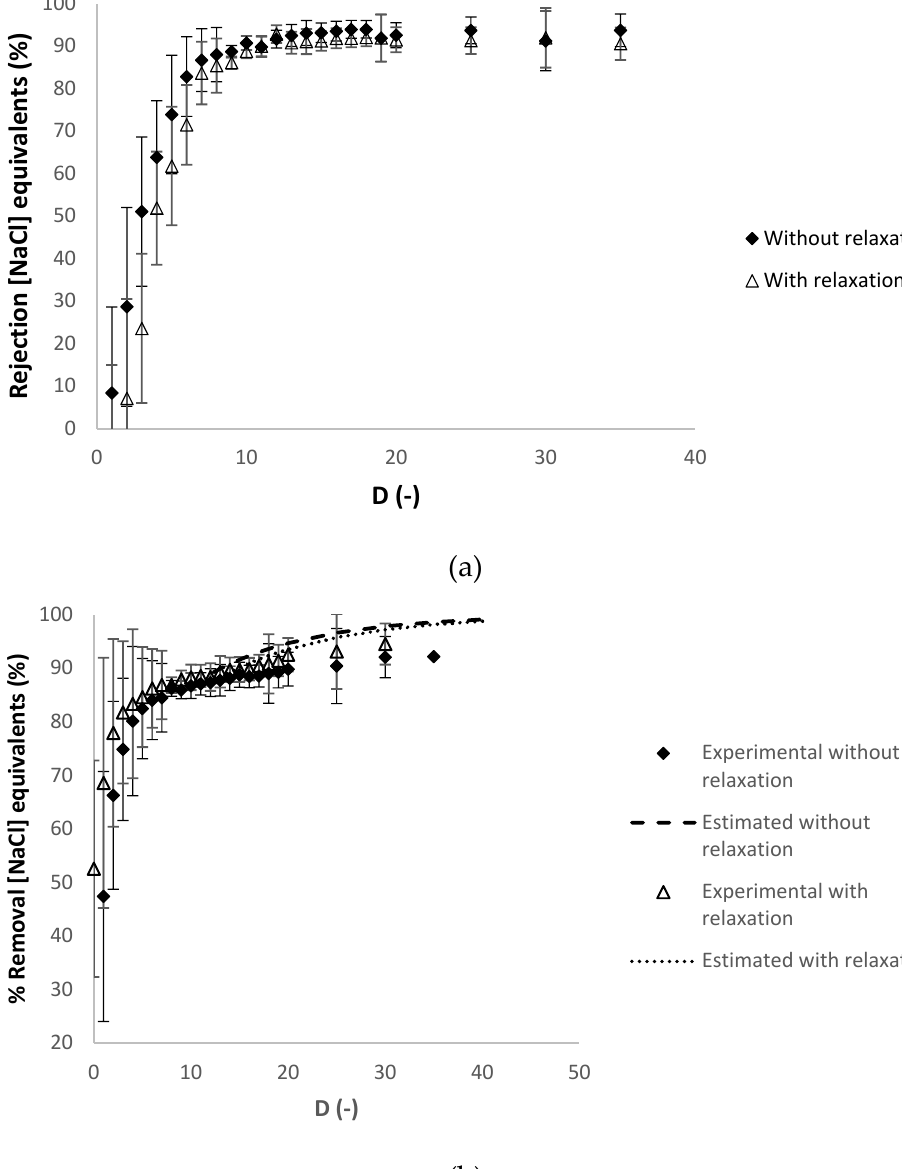
Figure 5. Dia-ultrafiltration with and without relaxation procedure with (diluted) arabinoxylans fraction as feed, at 40 ◦ C, with a Re feed of 184: ( a ) R NaCl (% NaCl.eq), apparent rejection in sodium chloride equivalents and ( b ) percentage of removal of charged contaminants in sodium chloride equivalents (NaCl.eq) against the D (-) diafiltration volume. Each analysis had duplicate measurements.